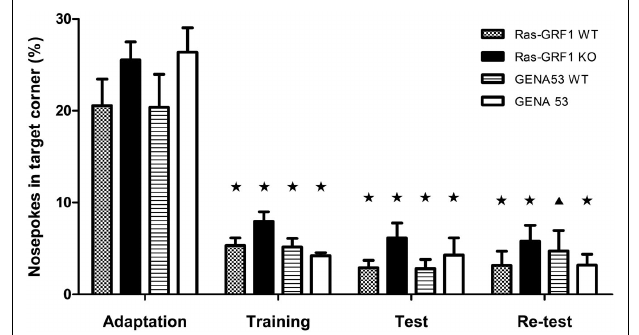
FIGURE 3 | Conditioned corner avoidance in Intellicage. Percentages (mean ± SEM) of first nosepokes (i.e., visits with a nosepoke) in the trained corner during the adaptation, training, test, and re-test phases. Ras-GRF1 WT ( n = 12); Ras-GRF1 KO ( n = 12); GENA53WT ( n = 12); GENA53 ( n = 11). Percentages of first nosepokes are compared with the basal percentages observed during the adaptation phase. P -value symbols: black star = p < 0.001; black triangle = p < 0.01; asterisk = p <